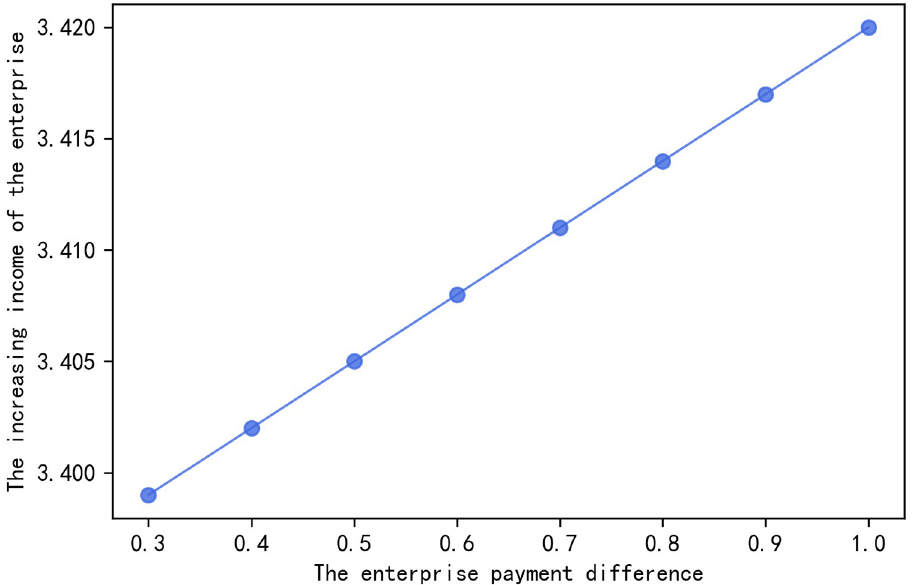
Fig 7. The relationship between enterprise’s added income and